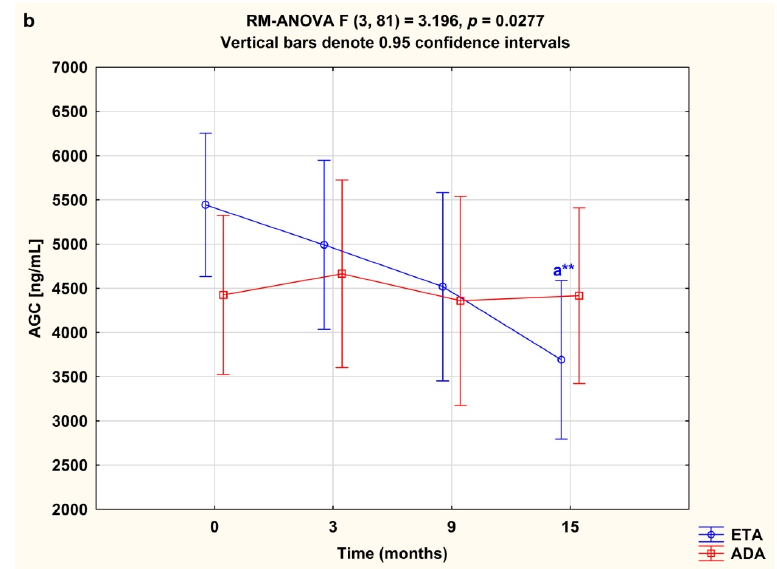
Figure 6. Temporal course of serum CS846 ( a ) and AGC ( b ) levels in RA patients during 15-month therapy with either etanercept ( n = 16) or adalimumab ( n = 13). Results expressed as mean (standard deviation, SD). Data not normally distributed (CS846) was log-transformed prior to analyses. Data analyzed using repeated measures analysis of variance (RM-ANOVA), followed by Turkey’s multiple comparisons test. a statistically significant differences compared to baseline. * p < 0.05; ** p < 0.01. AGC, aggrecan fragments; ADA, adalimumab; CS846, chondroitin sulfate epitope 846; ETA, etanercept. We also demonstrated that therapy with both etanercept and adalimumab decreased significantly the ADAMTS-4/TIMP-3 ratio ( p < 0.0083 and p < 0.001, respectively; Figure 7a). The ADAMTS-5/TIMP-3 ratio decreased in both etanercept- and adalimumab-treated RA patients as well ( p < 0.0083 and p < 0.001, respectively; Figure 7b).